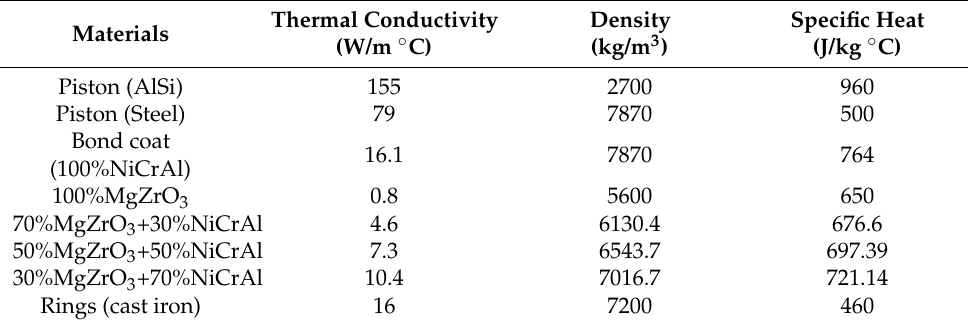
Table 2. Material properties of rigid elastic constituents.